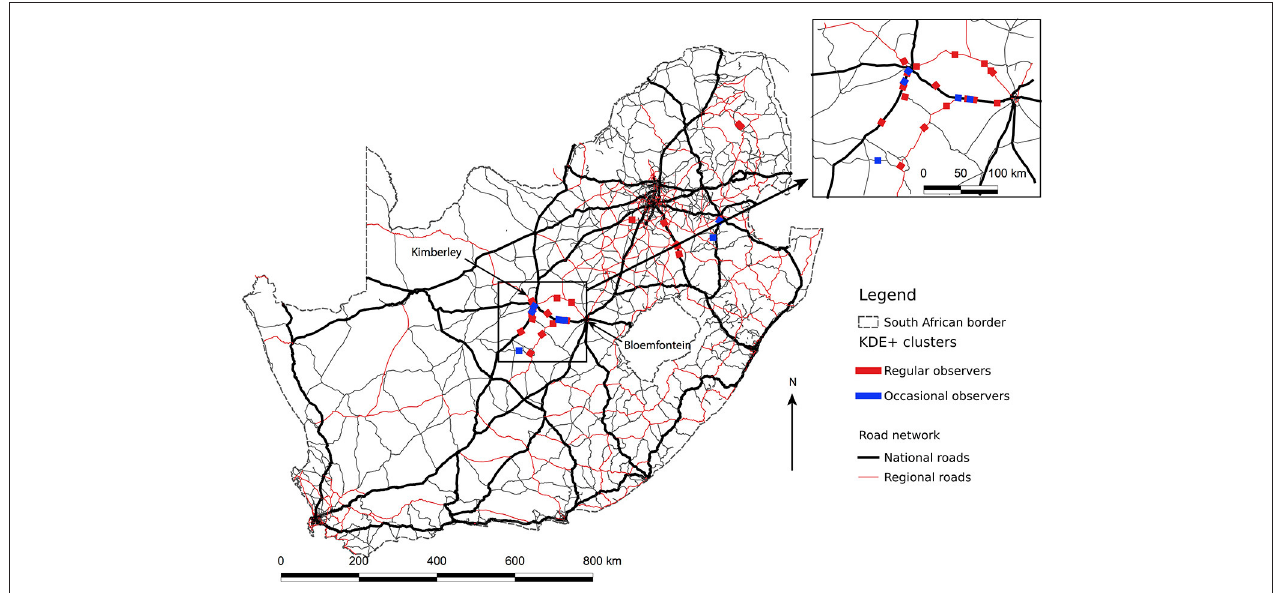
FIGURE 5 | Clusters of roadkill reported across South Africa from regular (red) and occasional (blue) reports using KDE + method. The insert shows the Bloemfontein-Kimberley region where most of the clusters are concentrated. Only clusters with a strength superior to 0.4 are